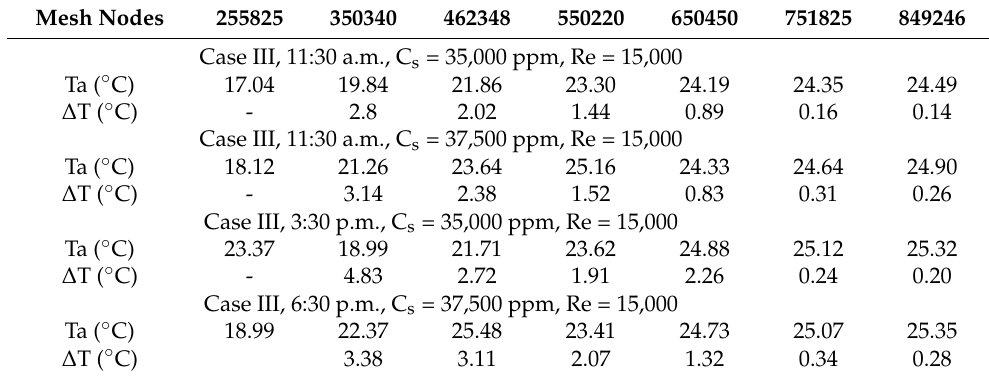
Table 2. Sensitivity analysis of the mesh for average air temperature inside the classroom. Mesh Nodes